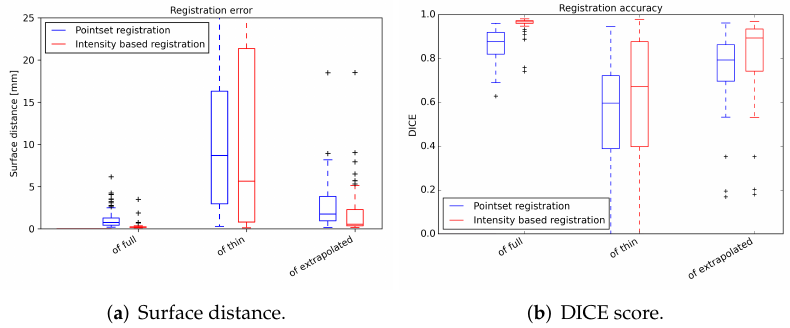
Figure 8. Registration results: landmark-based registration in blue, intensity-based registration in red. Each figure has three groups: left—registration of full-fixed with full-moving images; middle— registration of thin-fixed with full-moving images; right—registration of extrapolated-fixed with full-moving